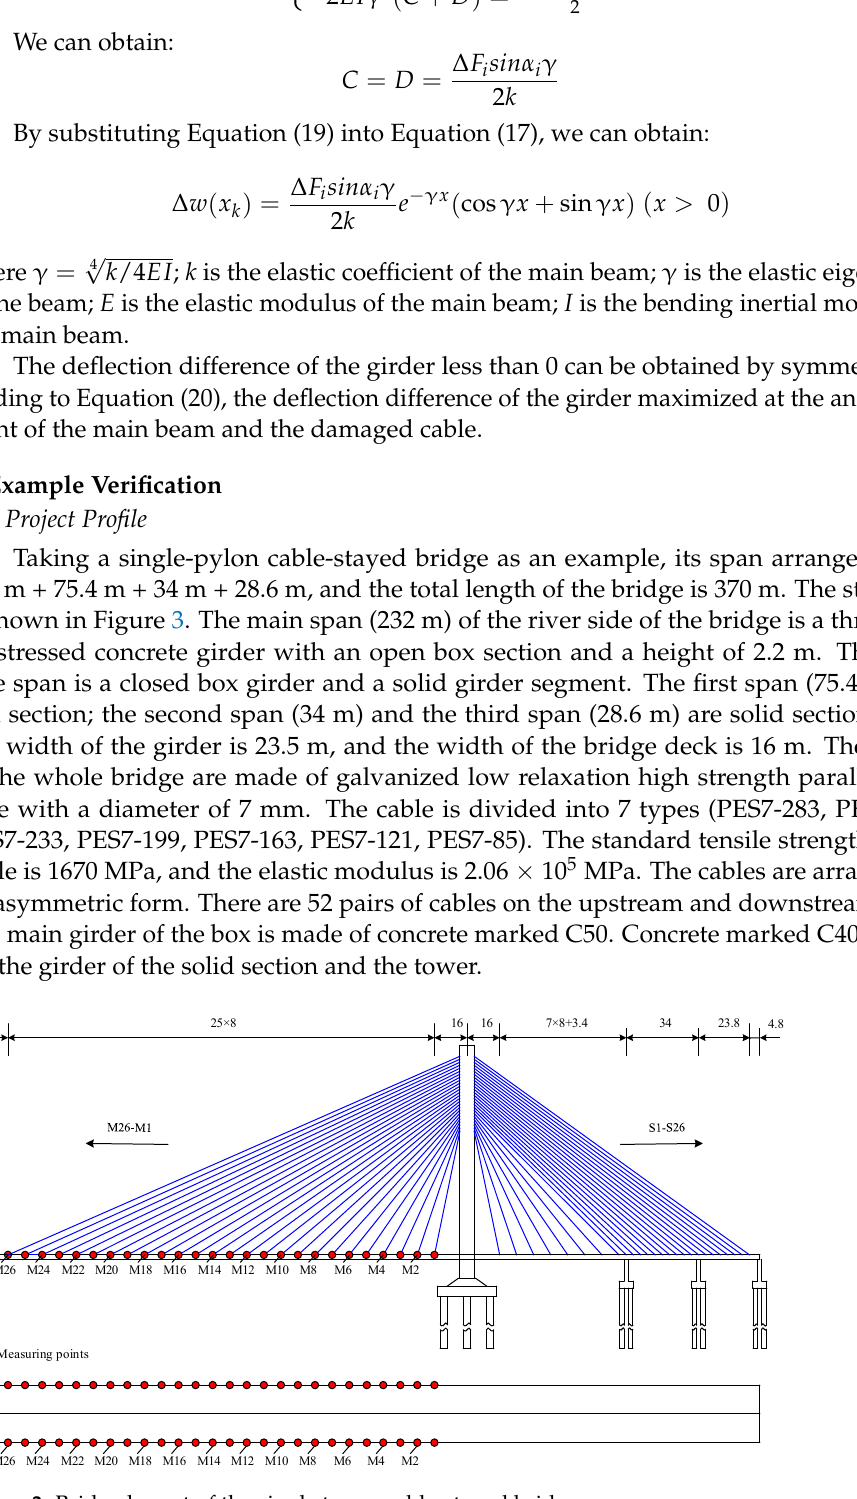
Figure 3. Bridge layout of the single tower cable-stayed